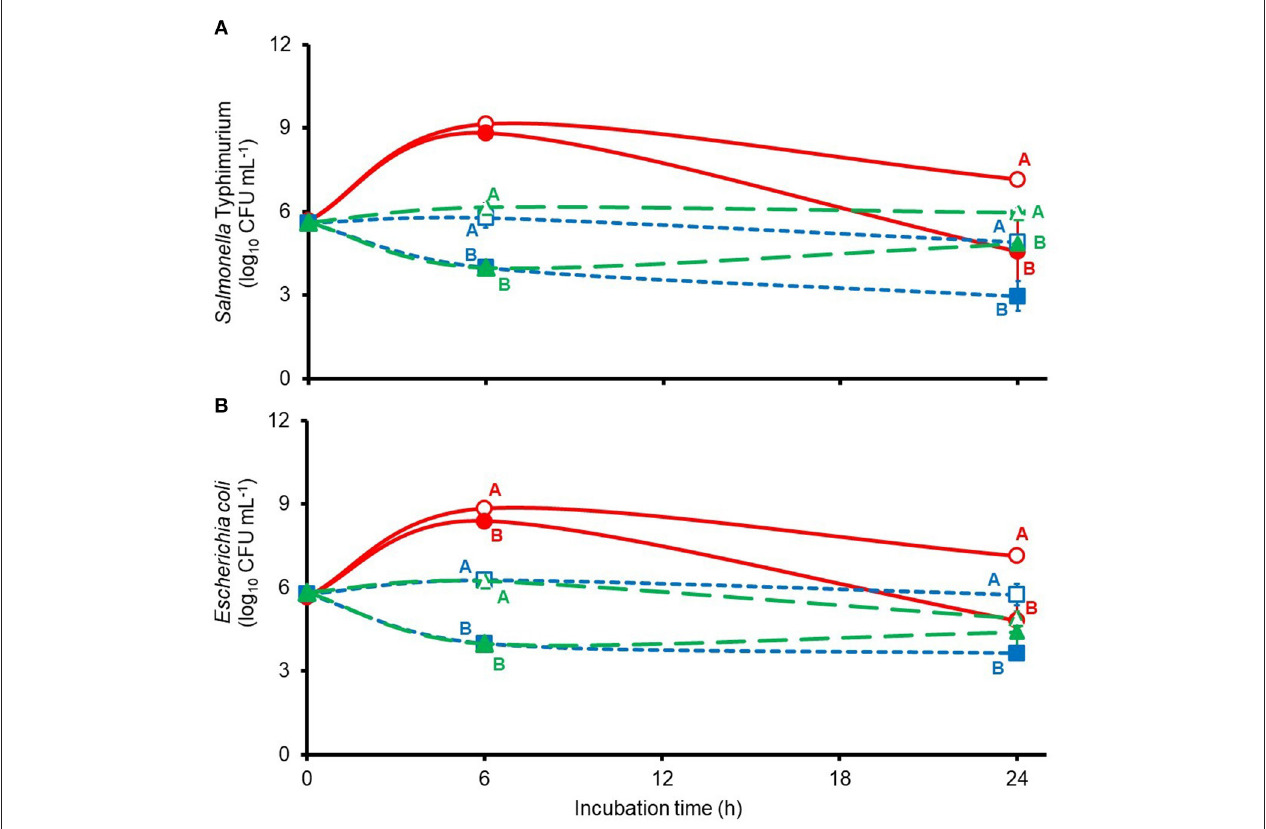
FIGURE 1 | Viable counts of challenge Salmonella Typhimurium [graph (A) ] or wild-type E. coli [graph (B) ] during mixed culture of porcine jejunal (solid red lines), cecal (dashed blue lines), or rectal bacteria (large dashed green lines) treated without (open symbols) or with 6mM thymol- β - D -glucopyranoside (filled symbols) in anaerobic (under 100% N 2 ) ½ -strength Muellar Hinton broth. Jejunal, cecal, and rectal means at each sample time accompanied by unlike uppercase red, blue, and green letters, respectively, differ based on least squares separation of means at p <